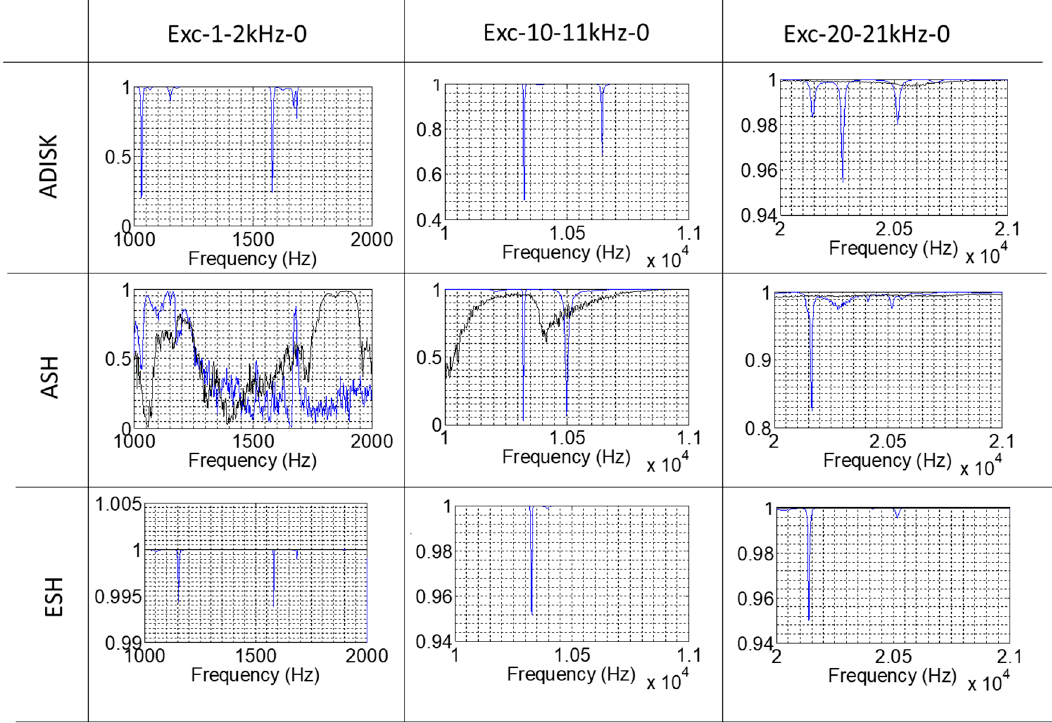
Figure 4. Coherence between the sensors of the rotating frame with respect to the PZT. The blue line is the “in air” configuration, and the black line is the “in water” configuration. Non-rotating case.